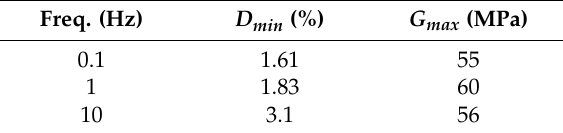
Table 3. Shear modulus and damping ratio of the tested material.